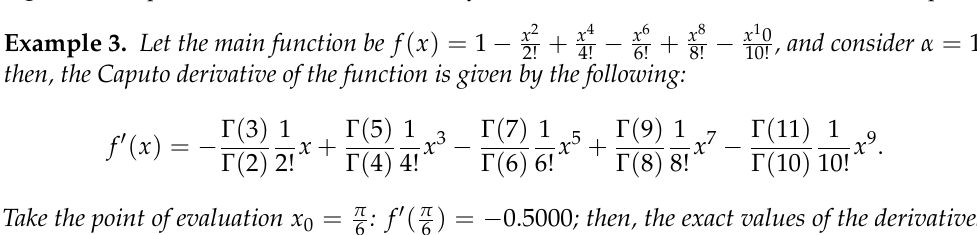
Figure 2. Comparison results between the analytical and fractional central formulas for Example 2.